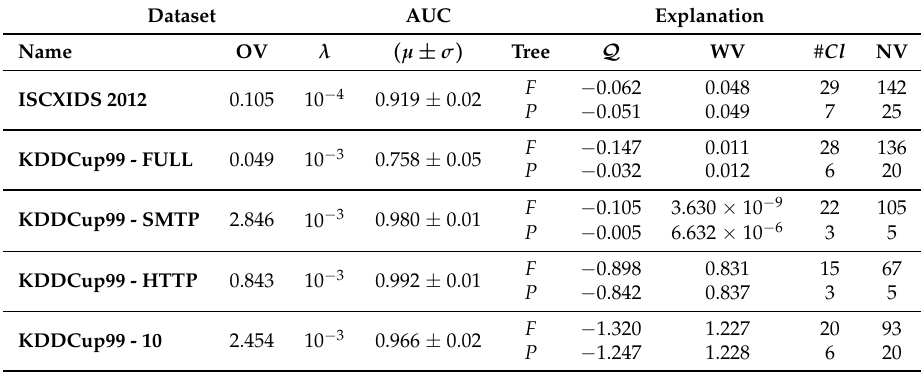
Table 1. Area under ROC curve (AUC) and explanatory tree metrics. Before pruning (Full, F ) and